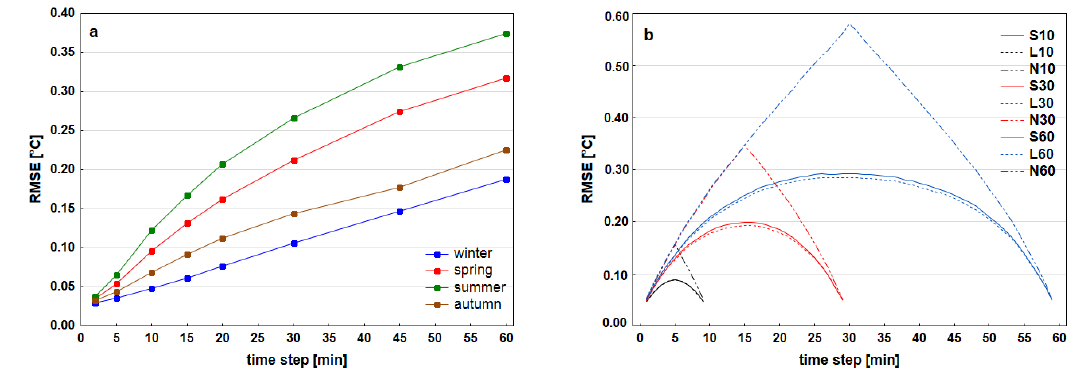
Figure 4. Seasonal accuracies of bilinear interpolation from 5-, 10-, 15-, 20-, 30-, 45- and 60-min time intervals ( a ) and comparison of accuracy of different time interpolation methods of 1-min air temperature data from 10-, 30- and 60-min time intervals on meteorological station Zby. ( b ): Bilinear interpolation (L10, L30, L60), last available value method (N10, N30, N60) and cubic splines interpolation (S10, S30, S60).